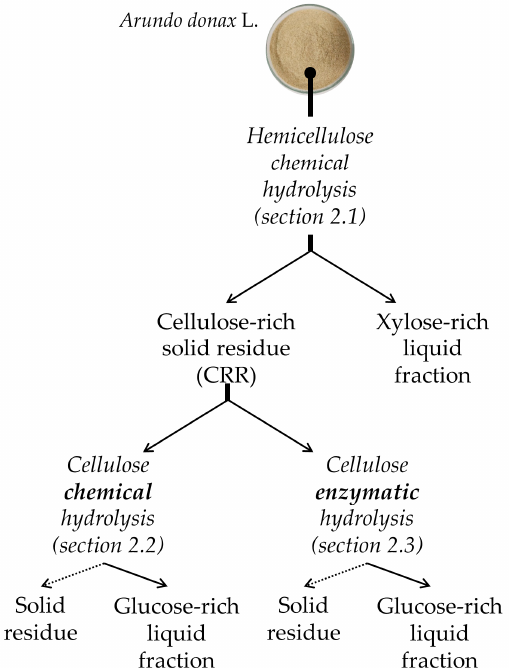
Figure 2. Diagram of the multi-step hydrolysis approach of Arundo donax L.